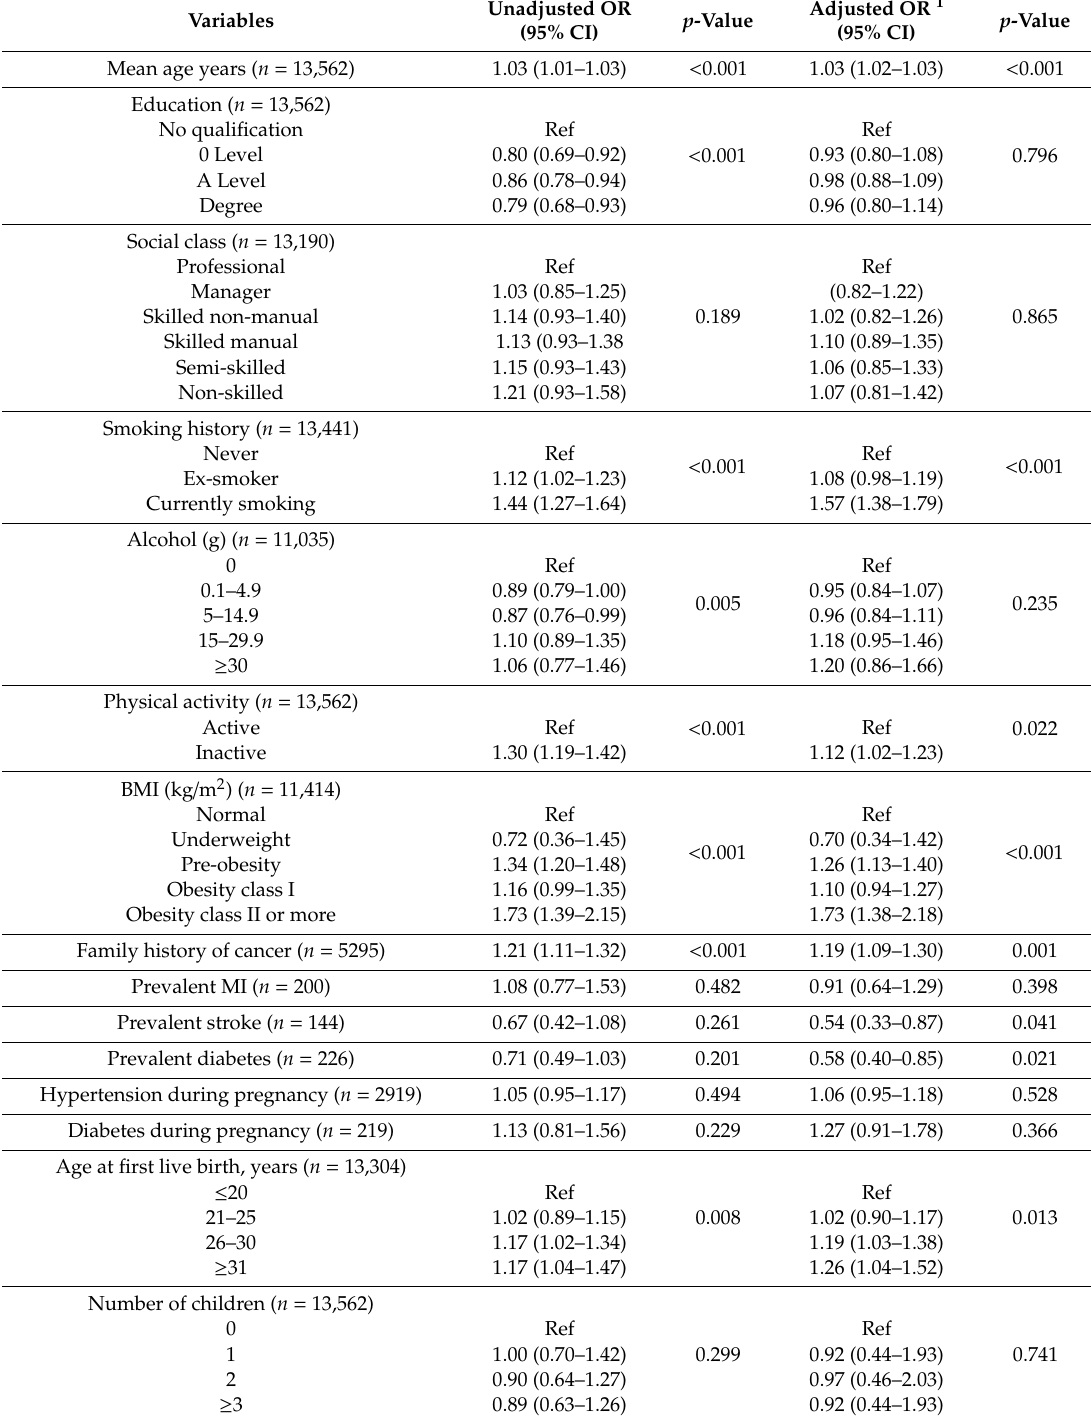
Table 2 details unadjusted and adjusted odds ratios of risk factors for incident cancer with corresponding 95% confidence intervals (95% CIs). HDP had no association with cancer in both univariable and multivariable analyses. In unadjusted analyses, HDP had OR 1.05; 95% CI 0.95–1.17. In the adjusted analysis, this did not change appreciably; 1.06; 95% CI 0.95–1.18. Table 2. Unadjusted and adjusted odds ratios and corresponding 95% confidence intervals for incident